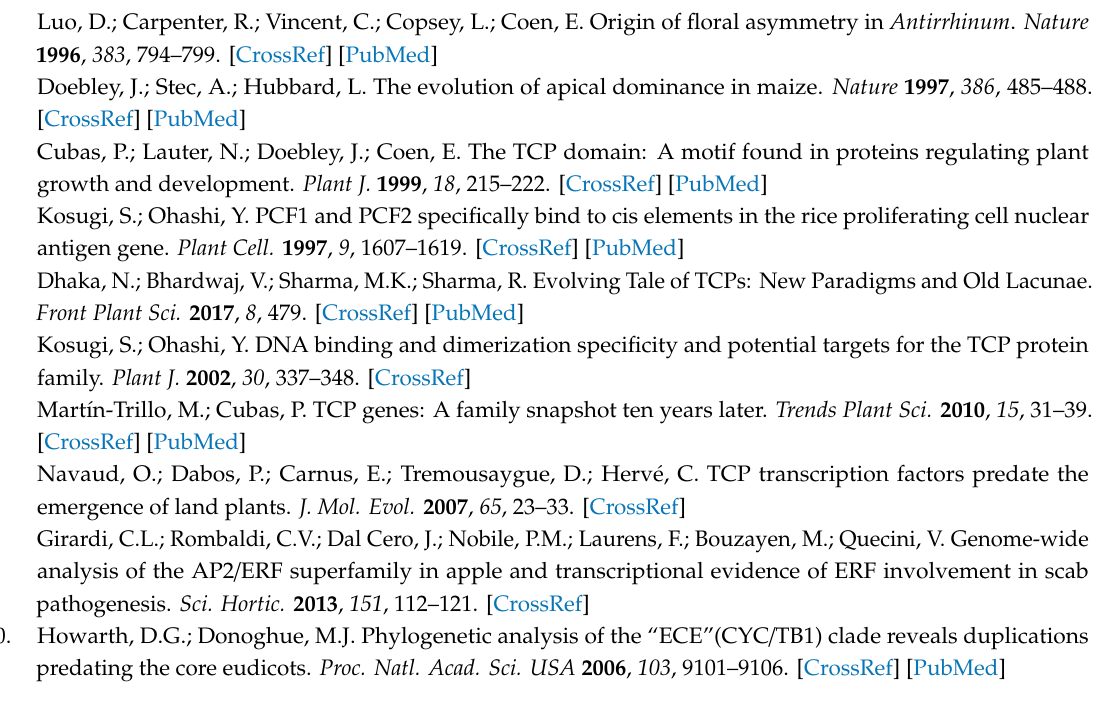
Figure S1: Quantitative assay results for GFP and FmTCP15 genes in transient overexpression of FmTCP15 seedlings, Table S1: Primers for quantitative RT-PCR (qRT-PCR), Table S2: Primers for yeast two-hybrid assay (Y2H), Table S3: Amino acid sequences for multiple sequence alignment, Table S4: Amino acid sequences for phylogenetic tree